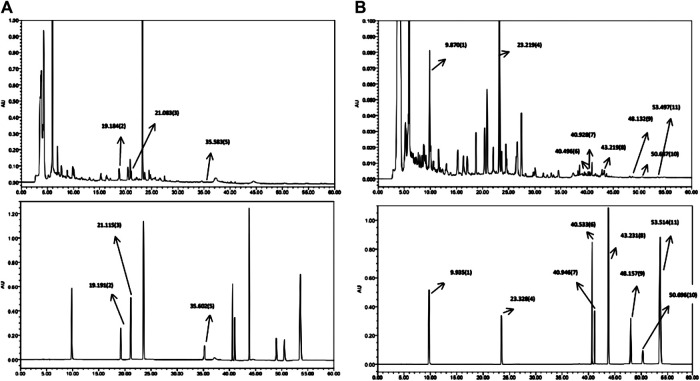
HPLC chromatogram of LTF. (A) Chromatogram at λmax = 210 nm. LTF is shown on top, while the reference standards are shown below. (B) Chromatogram at λmax = 254 nm. LTF is shown on top, while the reference standards are shown below.